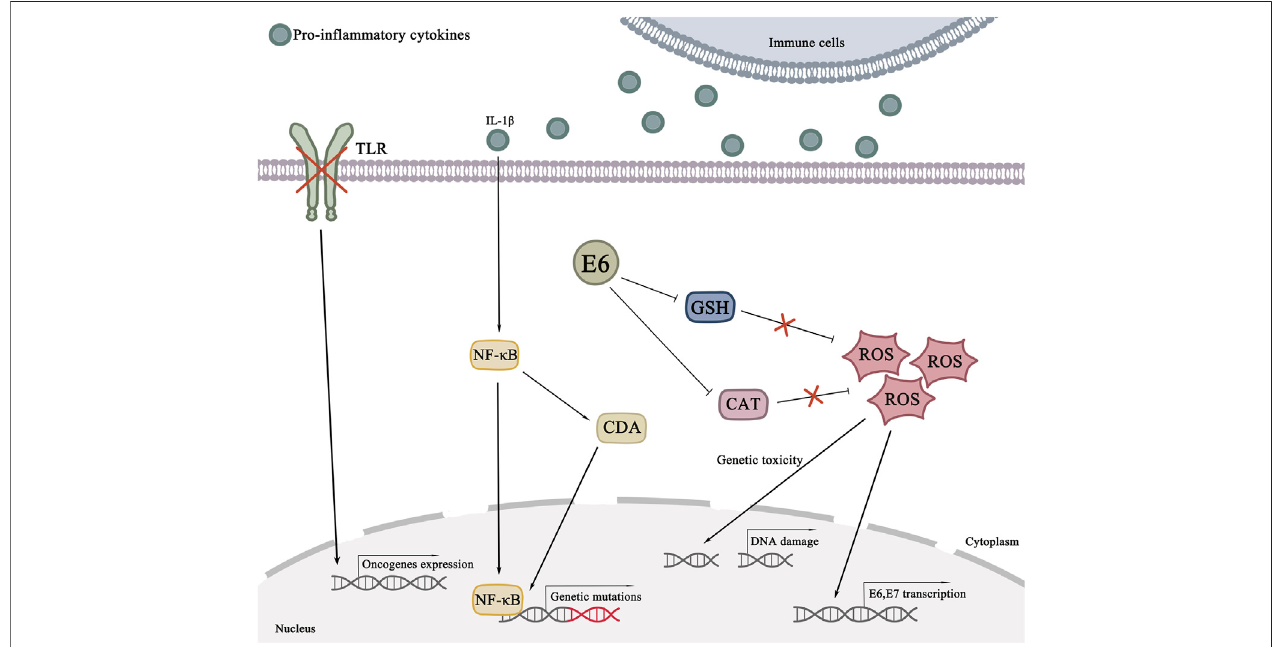
FIGURE 2 | Signaling pathways in the initial stage of cervical cancer cells. NF- κ B is activated by pro-in fl ammatory cytokines such as IL-1 β . NF- κ B can not only changecytosineintothymine,but alsoinduce CDAexpression, therebyinducinggenemutation.Theaccumulationofin fl ammatorycellsallowsROStoaccumulate.The buildup of ROS could cause DNA damage. HPV E6 oncoprotein can inhibit GSH and CAT. ROS is further